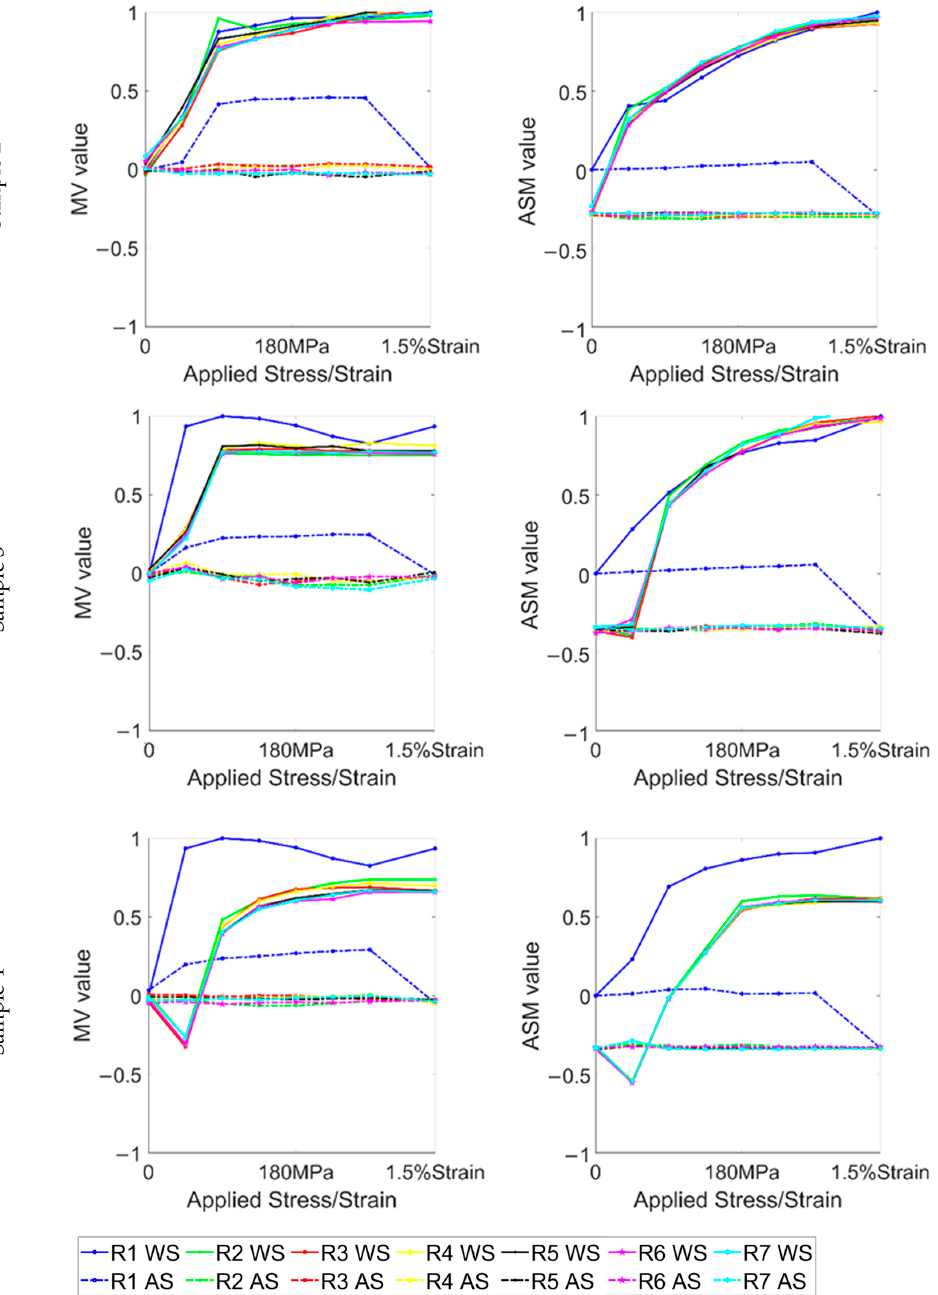
Figure 5. The relationship between RMF signal and applied stress/strain in the cyclic measurements.